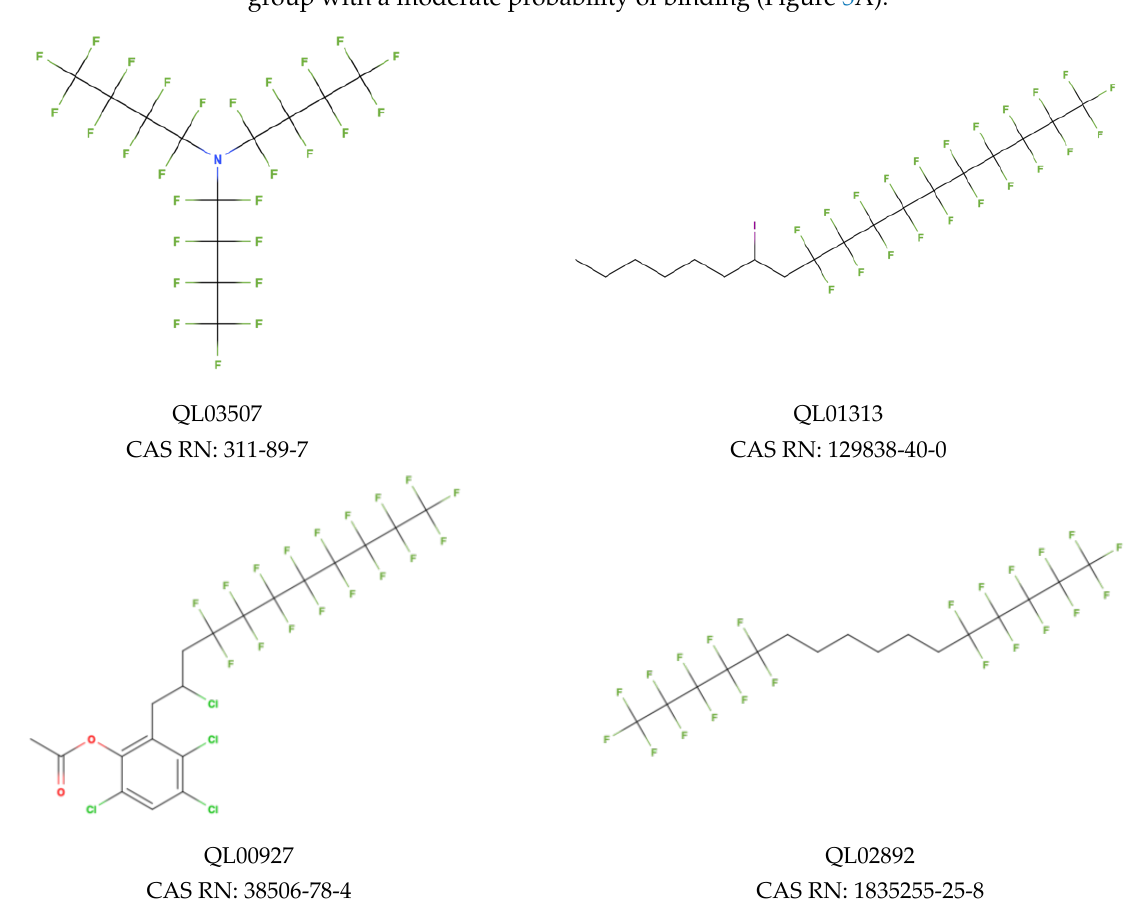
Figure 6. Chemical structure of PFAS selected from NORMAN Database.